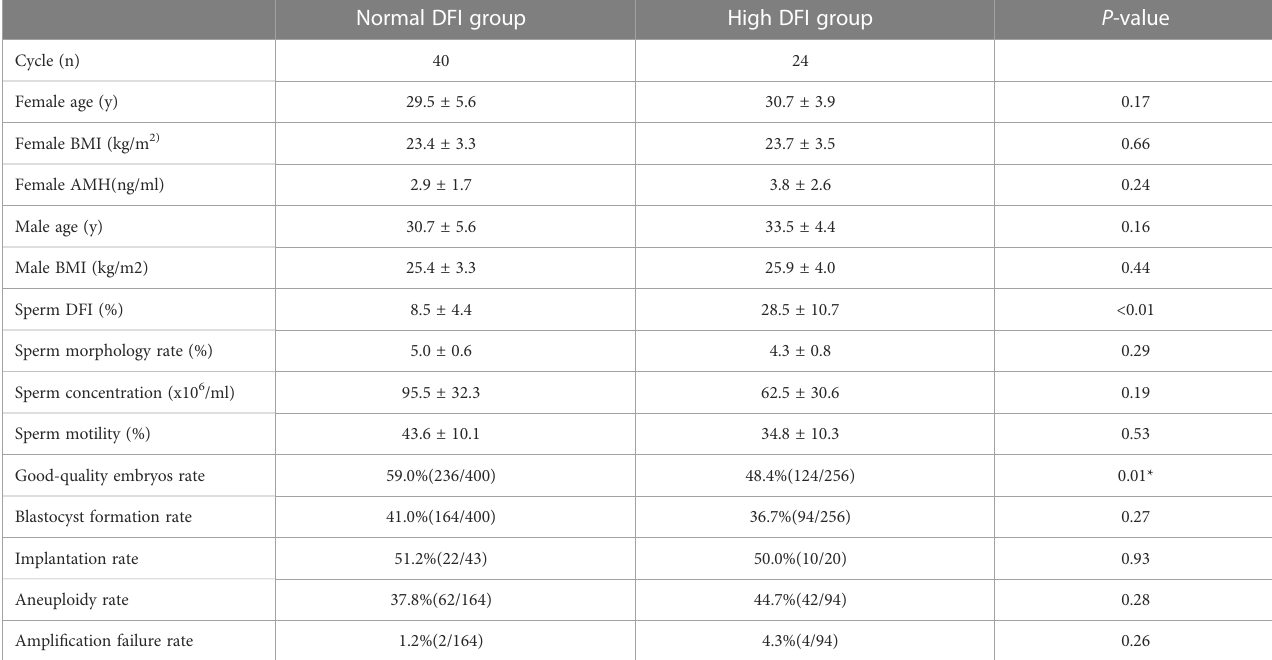
TABLE 2 Comparison of parameters between different sperm DFI groups.